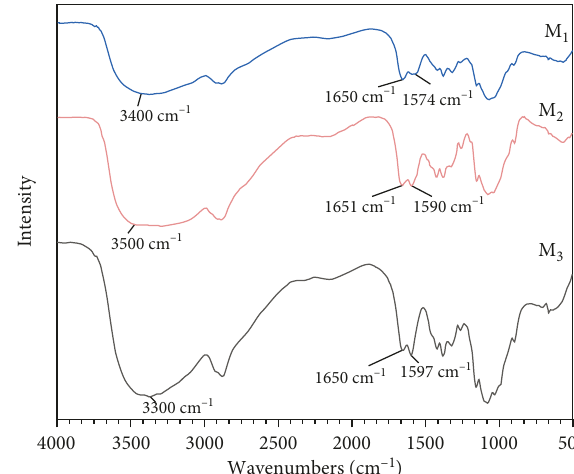
Figure 3: FTIR spectra of M1, M2, and M3. Effect of the DD on the surface tension of chitosan solution.